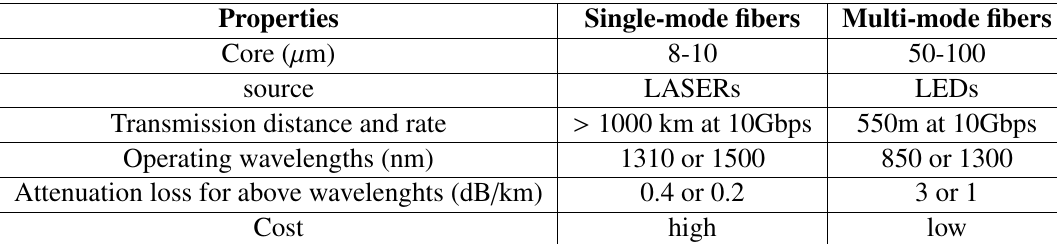
Table 1: Comparison between single-mode and multi-mode step-index optical fibers. Note that the above mentioned transmission distance and rates are for classical